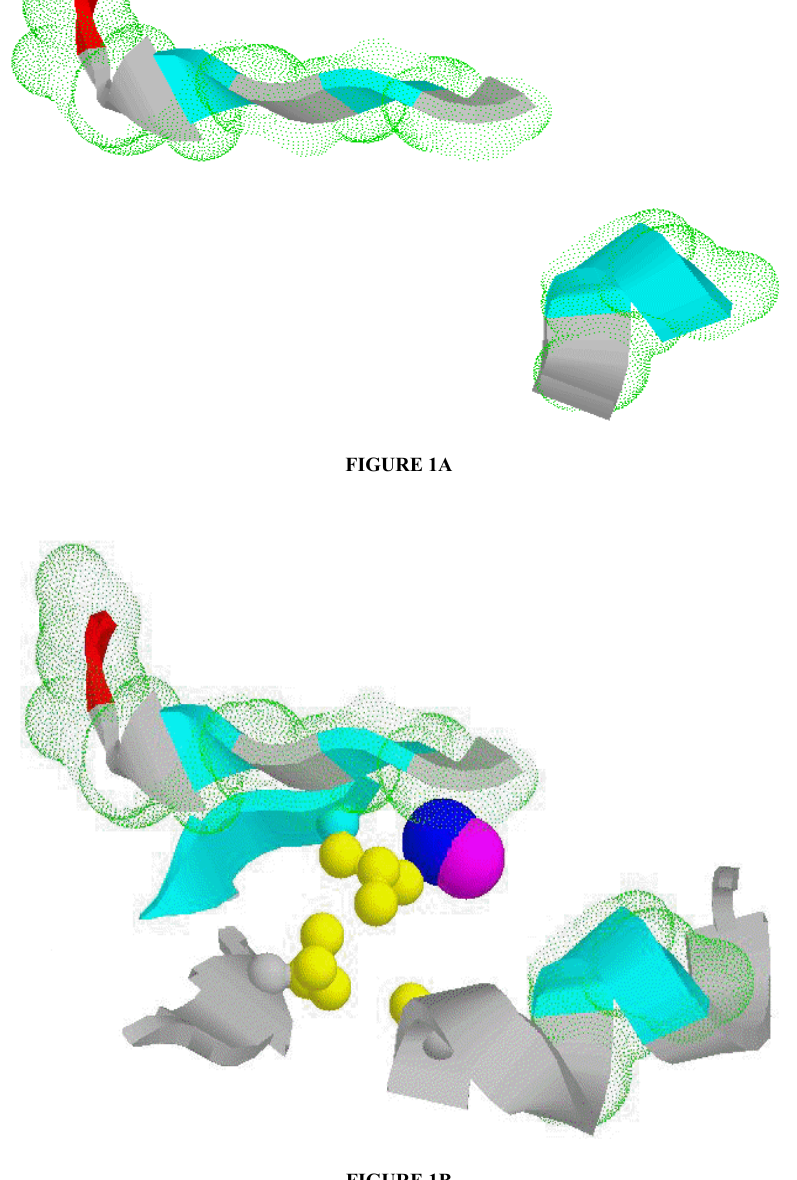
FIGURE 1. The four-stage scenario for the folding of a protein, illustrated on the example of chymotrypsin inhibitor 2 (PDB 1 ciq), see text for the details on biochemistry of CI2 folding. (A) Local hydrophobic collapse; (B) formation of the residue cluster(s) around the charge centers, then electrostatic collapse; (C) global hydrophobic collapse , formation of the active/binding site; (D) slow annealing to the native state. HX (hydrogen exchange) residues (cyan), continuous hydrophobic sequences (green dots), residues of folding nucleus (yellow), charge centers (positive, blue sphere, negative, red), and the binding site (loop colored in red) are